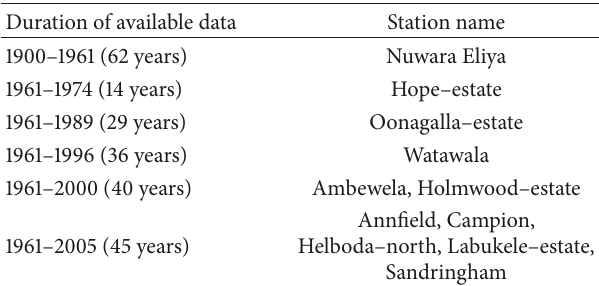
Table 1: Rainfall stations used for the study and duration of the